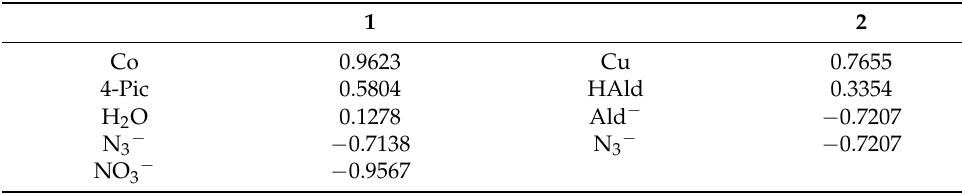
Table 9. The natural charges at metal center, ligand